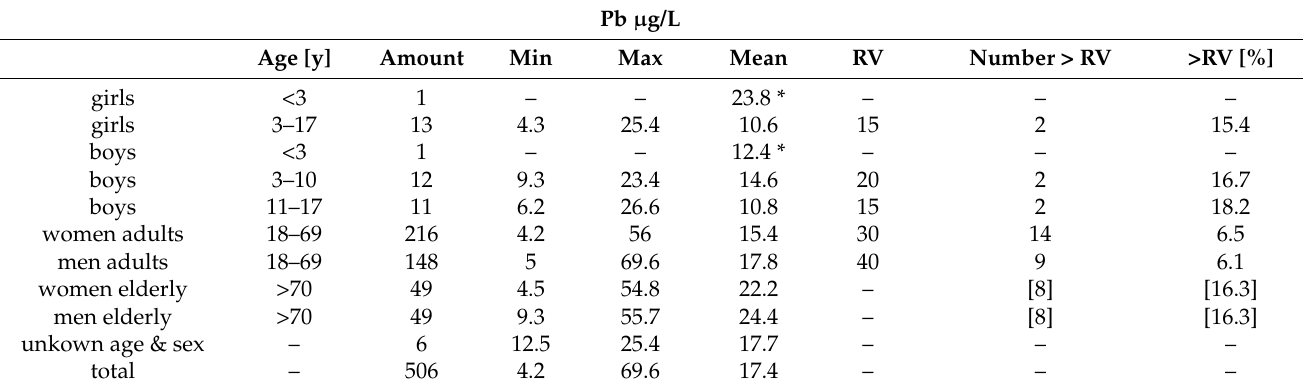
Table 1. BLL results depending on sex and age compared to available German RVs [23]. * Single measurement. In brackets []: Non-existing RVs; Data compared to adult RVs. Pb µ g/L Age [y] Amount Min Max Mean RV Number >